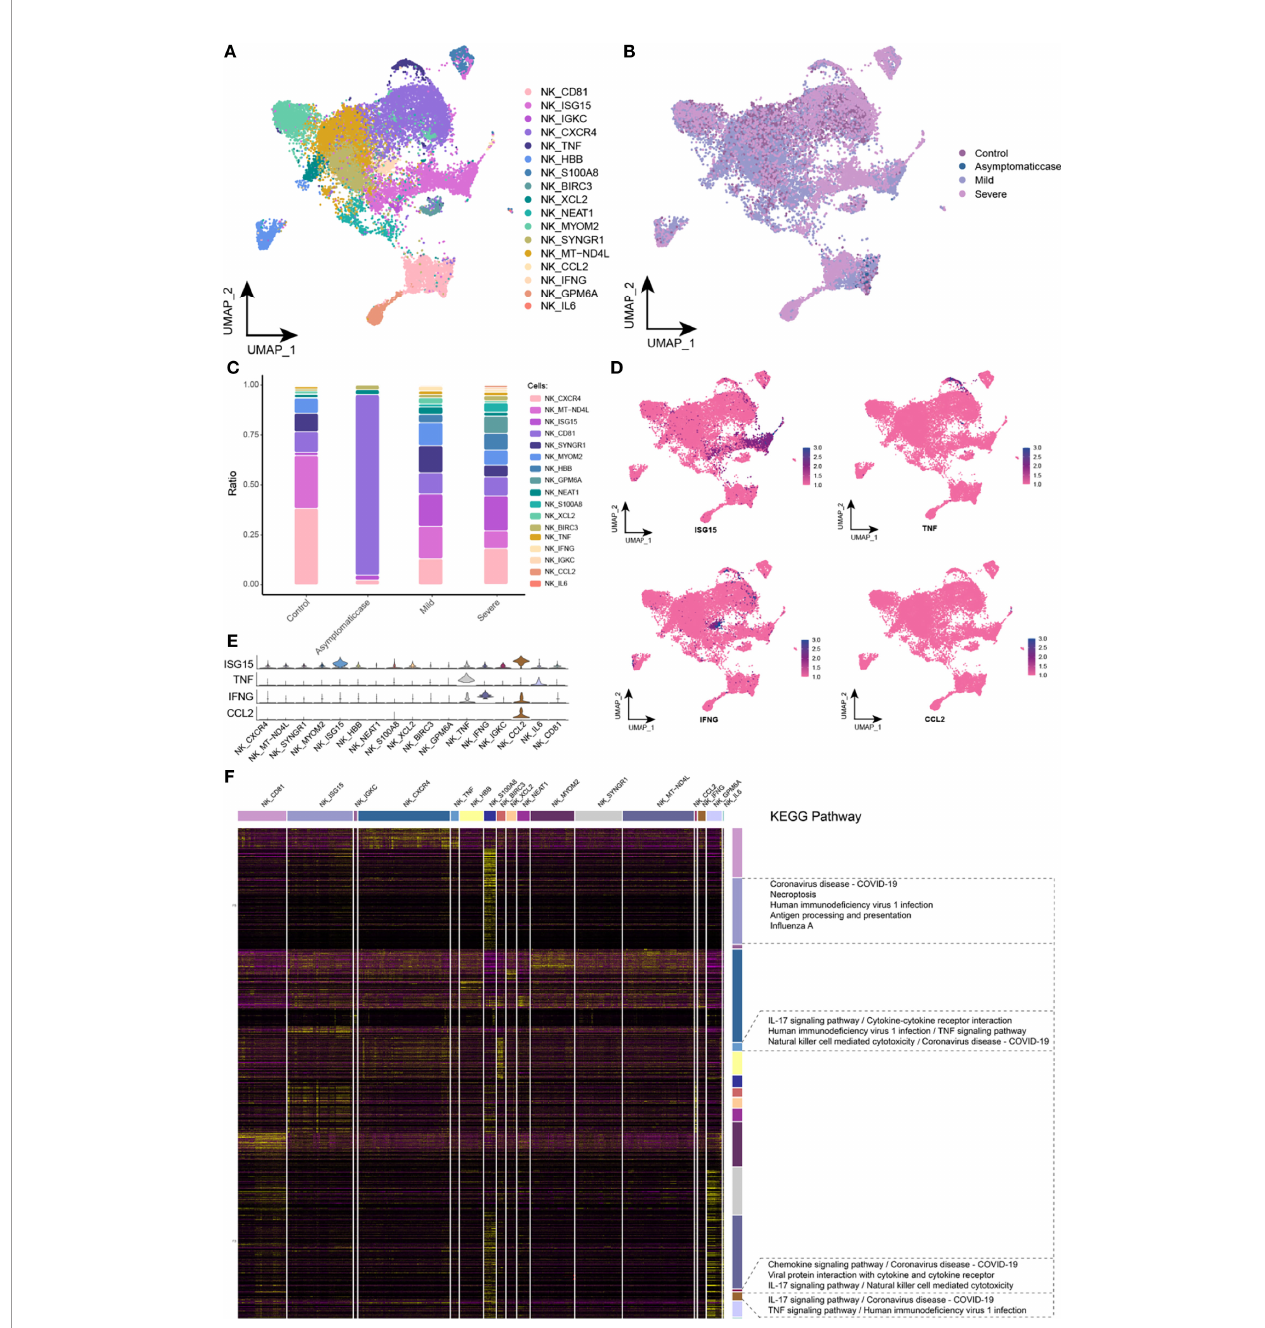
FIGURE 5 | Abnormal components of NK cell in patients with COVID-19. (A) Single-cell mapping of NK cell subsets. (B) Single-cell mapping of NK cells in the COVID-19 courses. (C) Components and changes of subpopulations of NK cells in the courses of new crowns. (D, E) Expression of marker genes in NK cell subsets. (F) Biological pathways involved in NK cell subsets with speci fi c changes. KEGG, Kyoto Encyclopedia of Genes and Genomes; NK, natural killer cell; UMAP, Uniform Manifold Approximation and Projection for Dimension